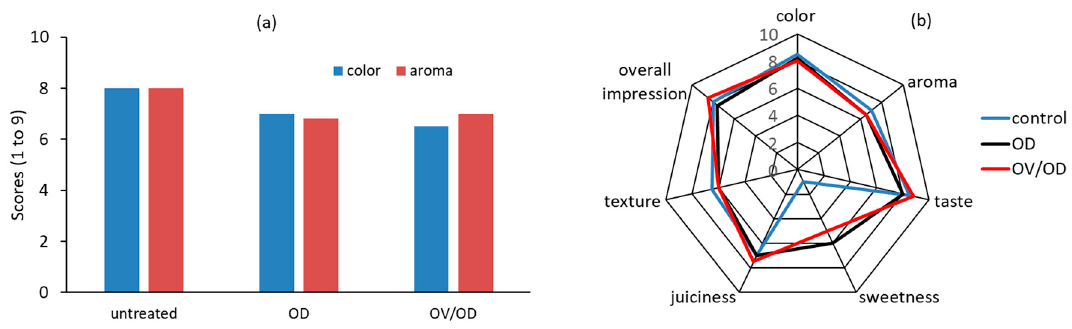
Figure 7. ( a ) Sensory evaluation of color and aroma of raw samples (at time zero of storage) and ( b ) sensory evaluation of cooked chicken fillets for all categories tested (untreated, OD and OV/OD).